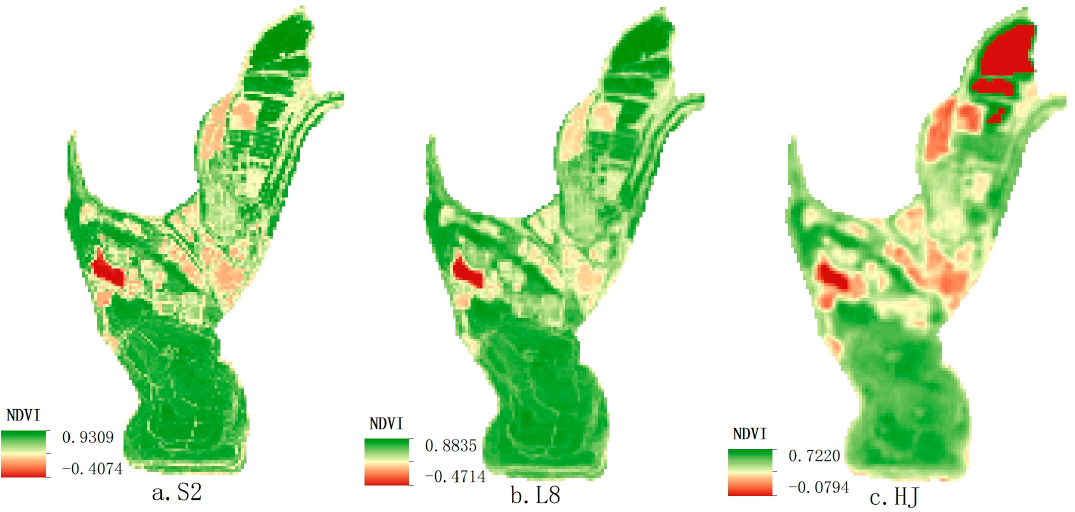
Figure 9. NDVI monitored by different satellite sensors in the Inner Dump (( a ): NDVI caculated from Sentinel-2(S2); ( b ): NDVI caculated from Landsat 8(L8); ( c ) NDVI caculated from